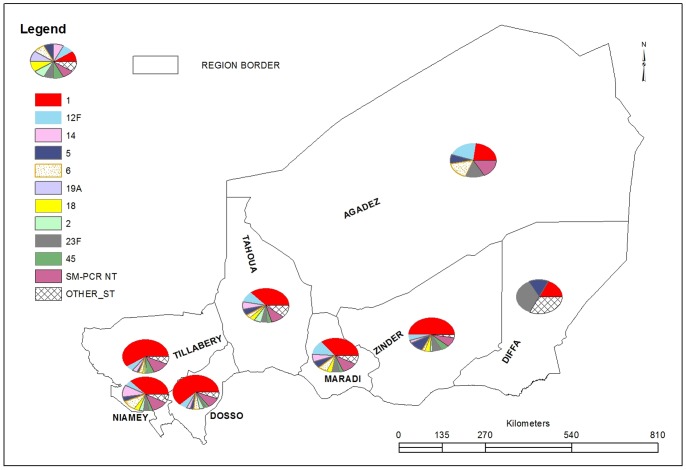
PM serotype distribution by Region, 2003–2011.